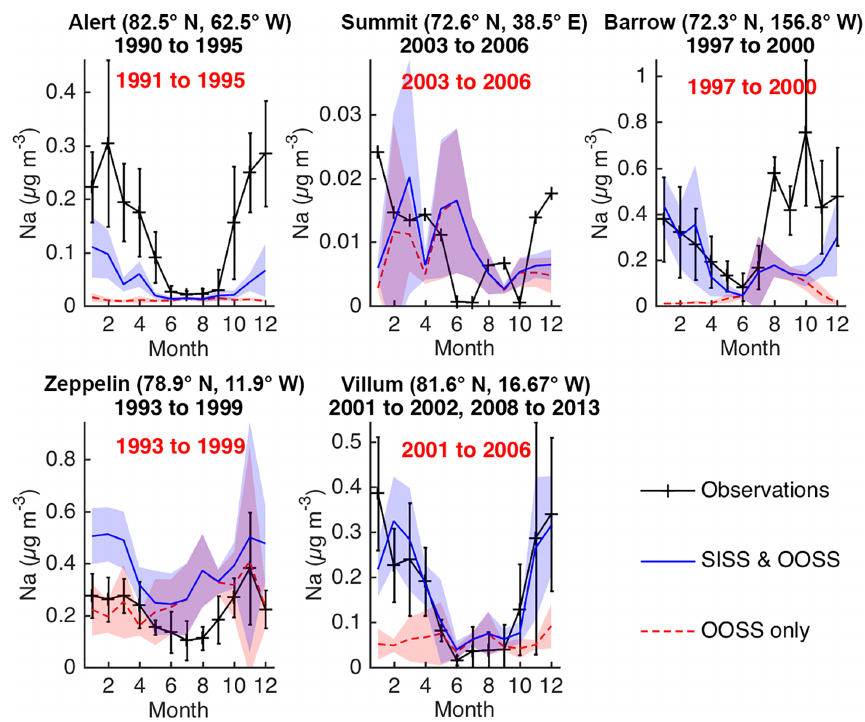
Figure 3. Sea salt Na aerosol concentrations at Arctic locations simulated by p-TOMCAT base simulation (Table 1) compared to observations. Date range of aerosol observations is displayed in black and date range of p-TOMCAT simulations is displayed in red on each subplot. Observations and model results are mean monthly values with uncertainty bars or shaded bounds representing ± 1 σ of the inter-annual variability. The Summit observations are not plotted with uncertainty bars because temporal coverage of data set is too poor